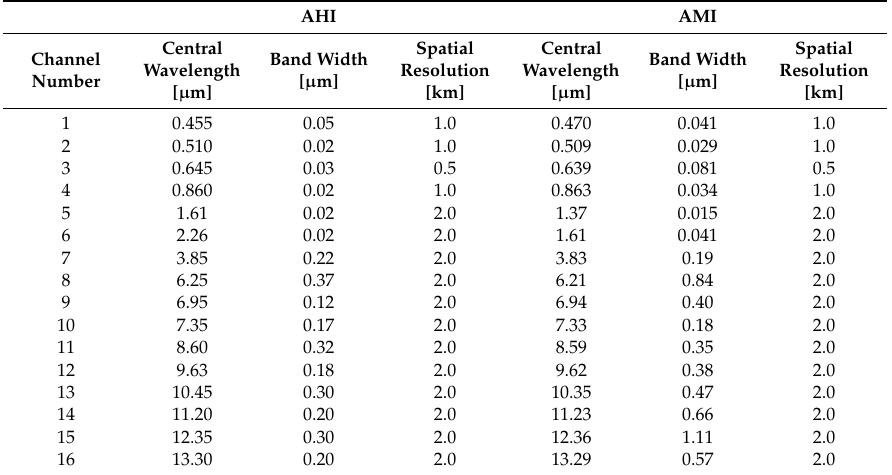
Table 1. Comparisons between characteristics of the Advanced Himawari Imager (AHI) and Advanced Meteorological Imager